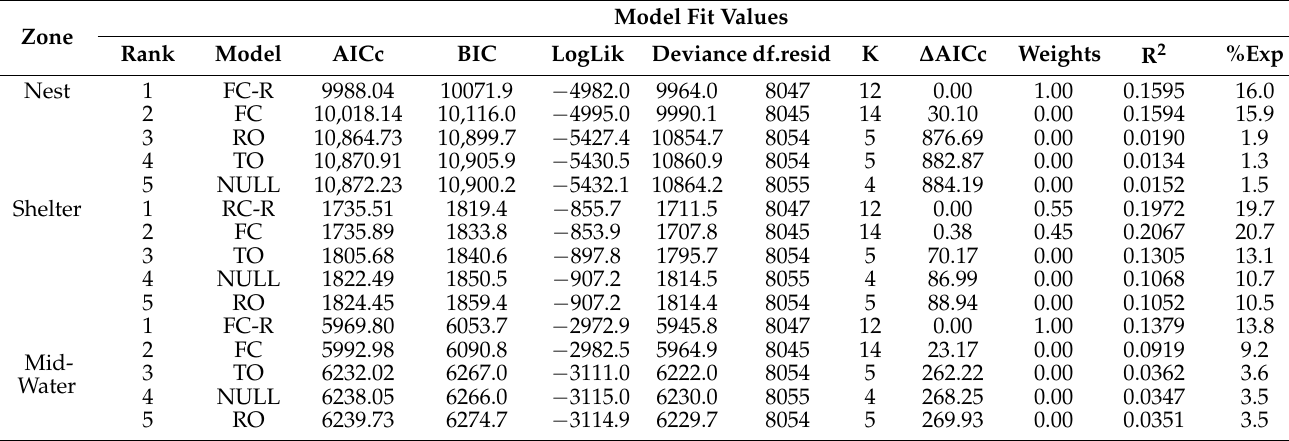
Table A3. Model fit values of binomial GLMMs explaining chicks occupancy in enclosure zones.